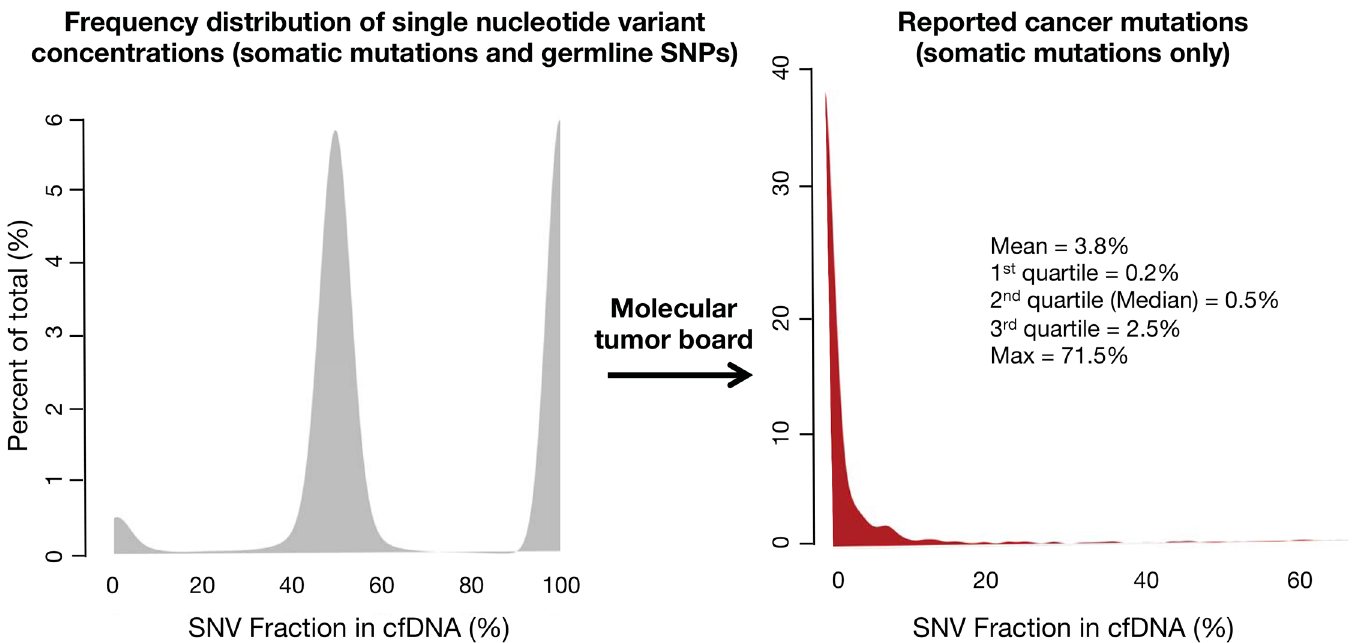
Fig 6. Frequency distribution of single nucleotide variant (SNV) mutant allele fractions (MAFs) for the first 1,000 consecutive patients tested in clinical practice (broad range of non-hematologic malignancies). On the left the three peaks represent kernel distribution density plots of the frequencies of somatic and germline mutant allele fractions. By their low concentrations, somatic mutations (far left-hand small peak) can be generally distinguished from heterozygous germline SNVs around 50% MAF (middle peak) and homozygous germline SNVs around 100% MAF (right-hand peak). Cell-free DNA is both leukocyte-derived and tumor-derived, with the germline DNA generally representing the bulk of the cfDNA. On the Guardant360 panel the molecular tumor board filters out the germline SNVs and only the somatic mutations are reported. The red curve in the right-hand figure shows the frequency distribution of the MAFs for the somatic SNVs only. The long tail reflects the rare patients with a somatic mutation at high MAF.